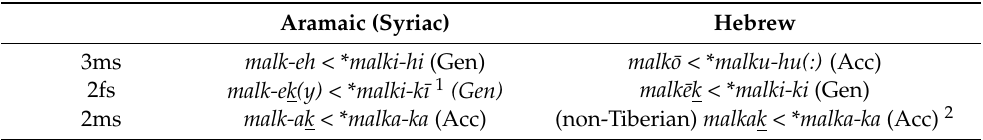
Table 2. Reconstructed Aramaic (Syriac) and Hebrew Pronominal